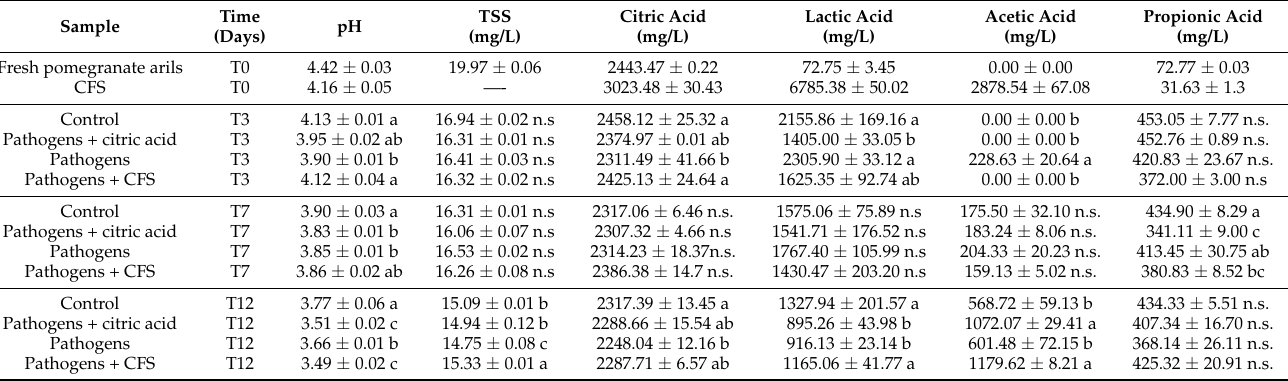
Table 6. Chemical analyses and organic acids detected by HPLC in pomegranate aril samples during